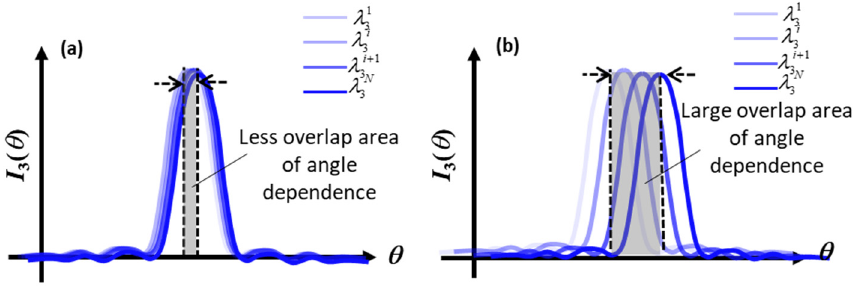
Figure 4. ( a ) The diagram of dispersion-less angle dependence I 3 ( θ ); ( b ) The diagram of dispersive angle dependence I 3 ( θ ).